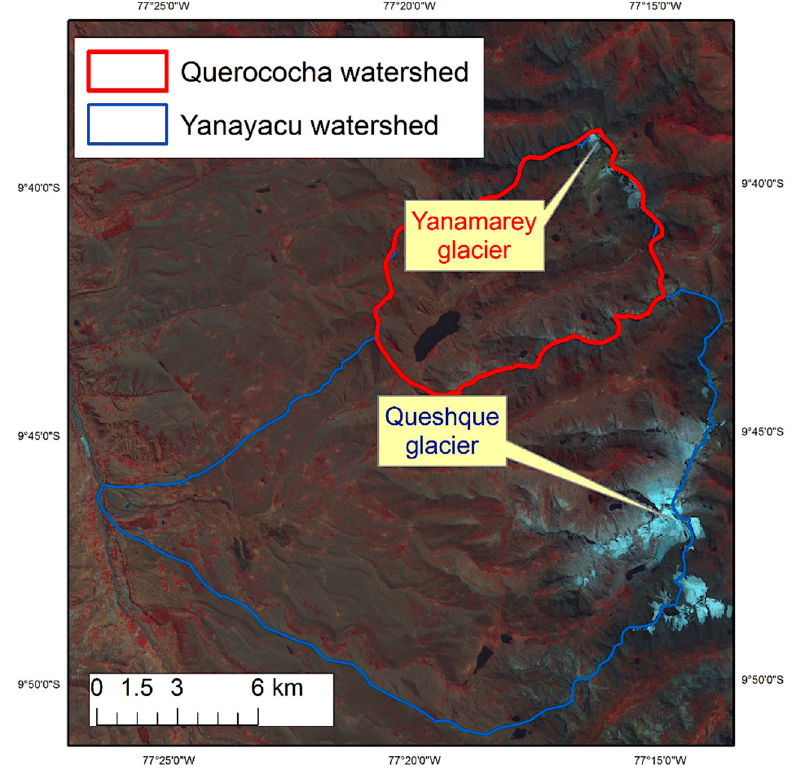
Figure 1. Yanamarey and Queshque main glaciers in the study area. The background is a false color composite (Bands 3, 2, and 1) ASTER image (take on 12 August 2005; downloaded from https://lpdaac.usgsu.gov). The Querococha flows into the Santa